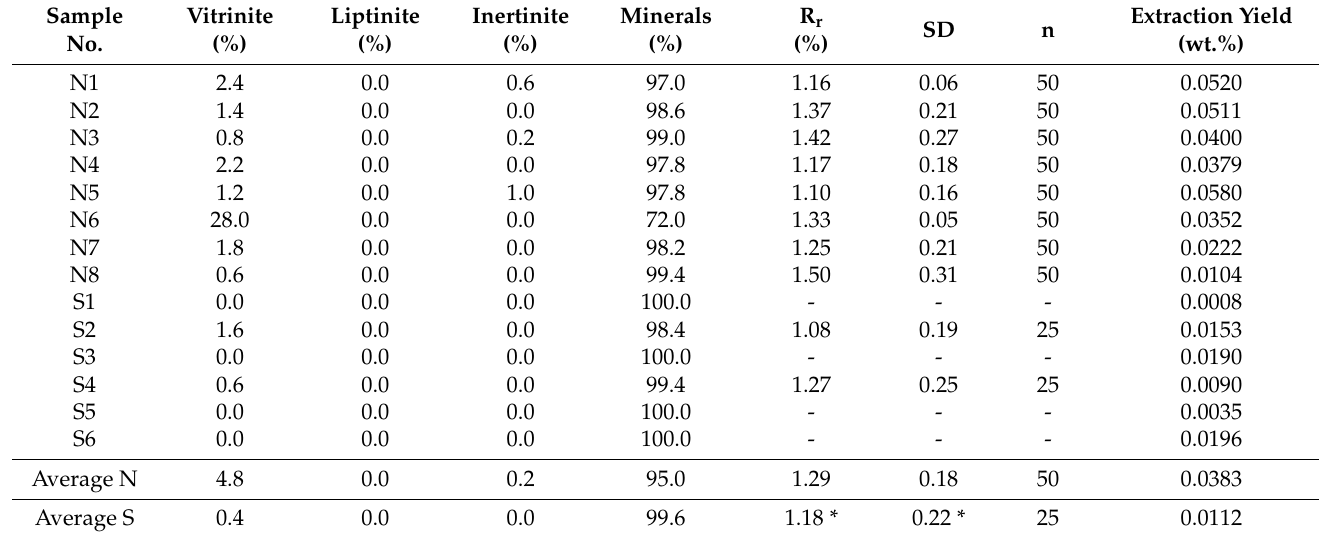
Table 1. Petrographic properties and extraction yields of the gangue-rocks samples from the northern (N1–N8) and southern (S1–S6) parts of the Jas-Mos mining area, a part of the Jastrz˛ebie-Bzie Coal Mine.